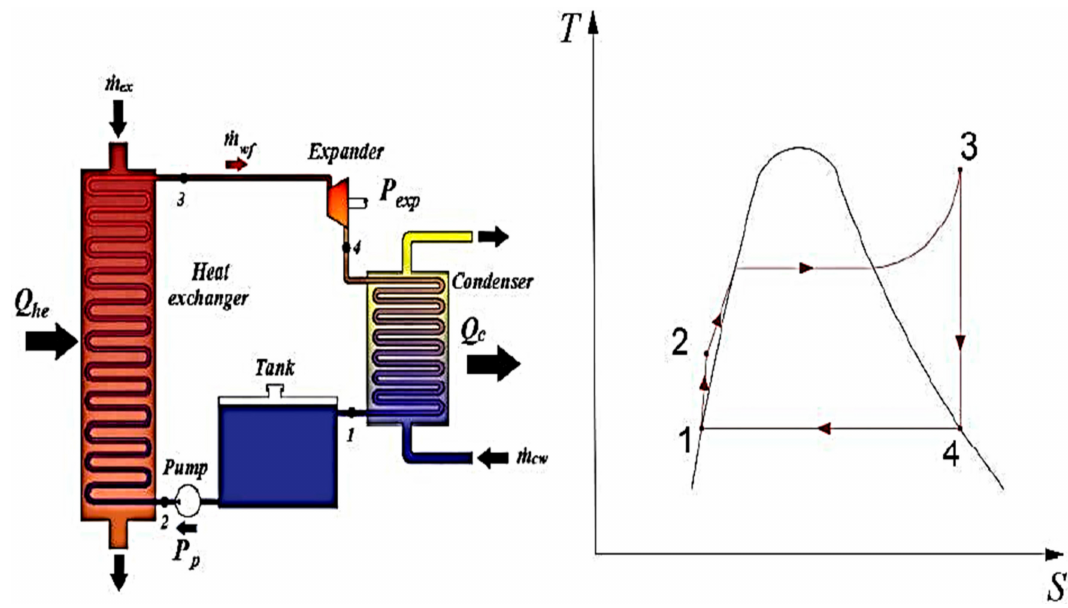
Figure 7. Rankine Cycles System and the T-S Diagram of the Processes